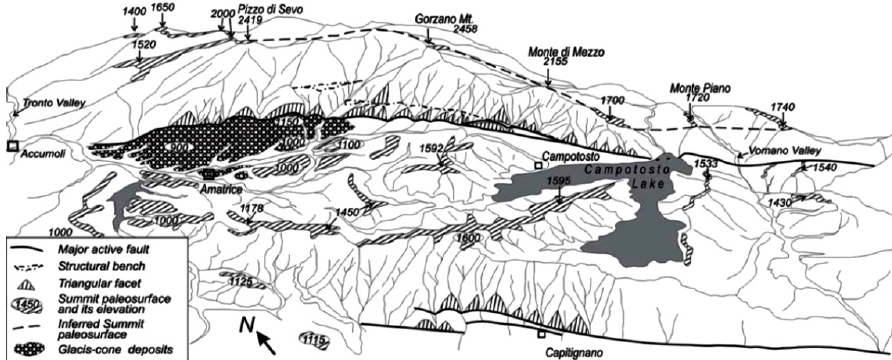
Figure 2. Geomorphological map of the study area. Map taken from [45]. Geosciences 2020 , 10 , x FOR PEER REVIEW